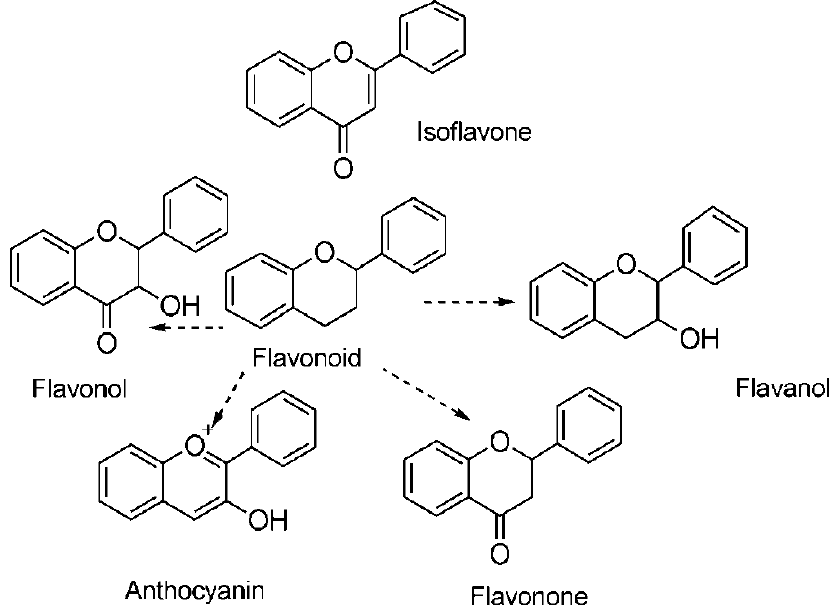
Figure 3. Chemical structure of flavonoids (Reprinted with permission from Ref. [103] , 2020, Ullah et al.).